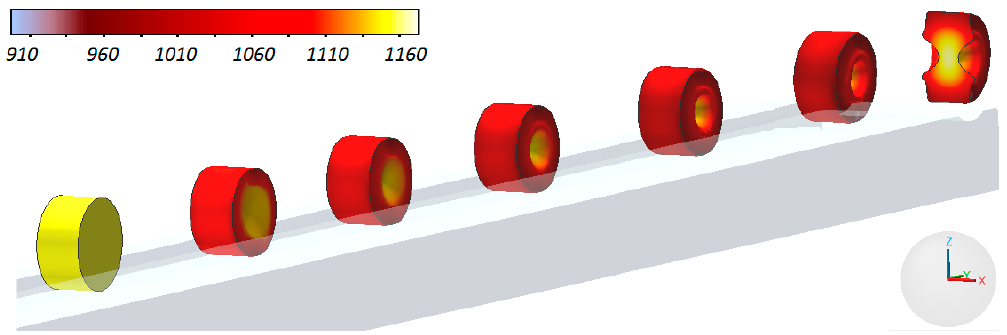
Figure 11. Progression of the sample shape during rotational compression in a channel on the path s = 700 mm with the material temperature distribution.